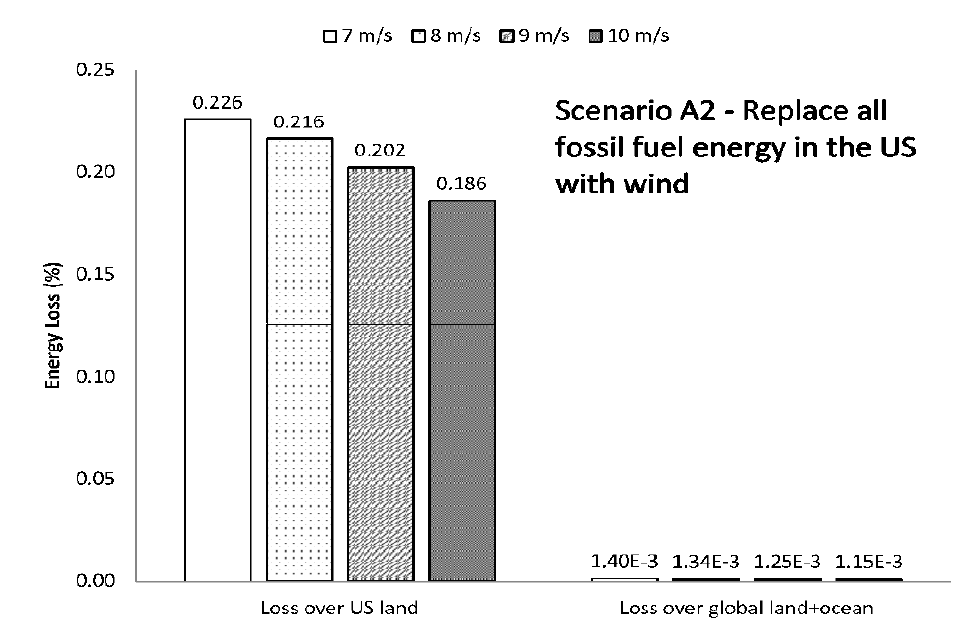
Figure 12. Energy loss (%) for Scenario A2, where wind farms supply U.S. energy. Similar to the previous figure, the first set of bars represents the relative loss in the entire boundary layer, and the second set represents the relative loss in the boundary layer just above the U.S. The number of turbines for each wind speed is given in Table 3.